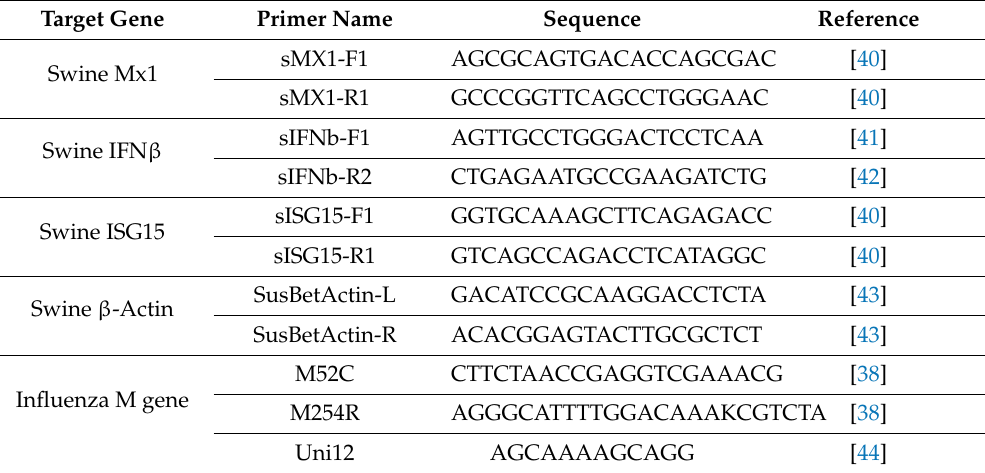
Table 1. Primers used for quantitative real-time